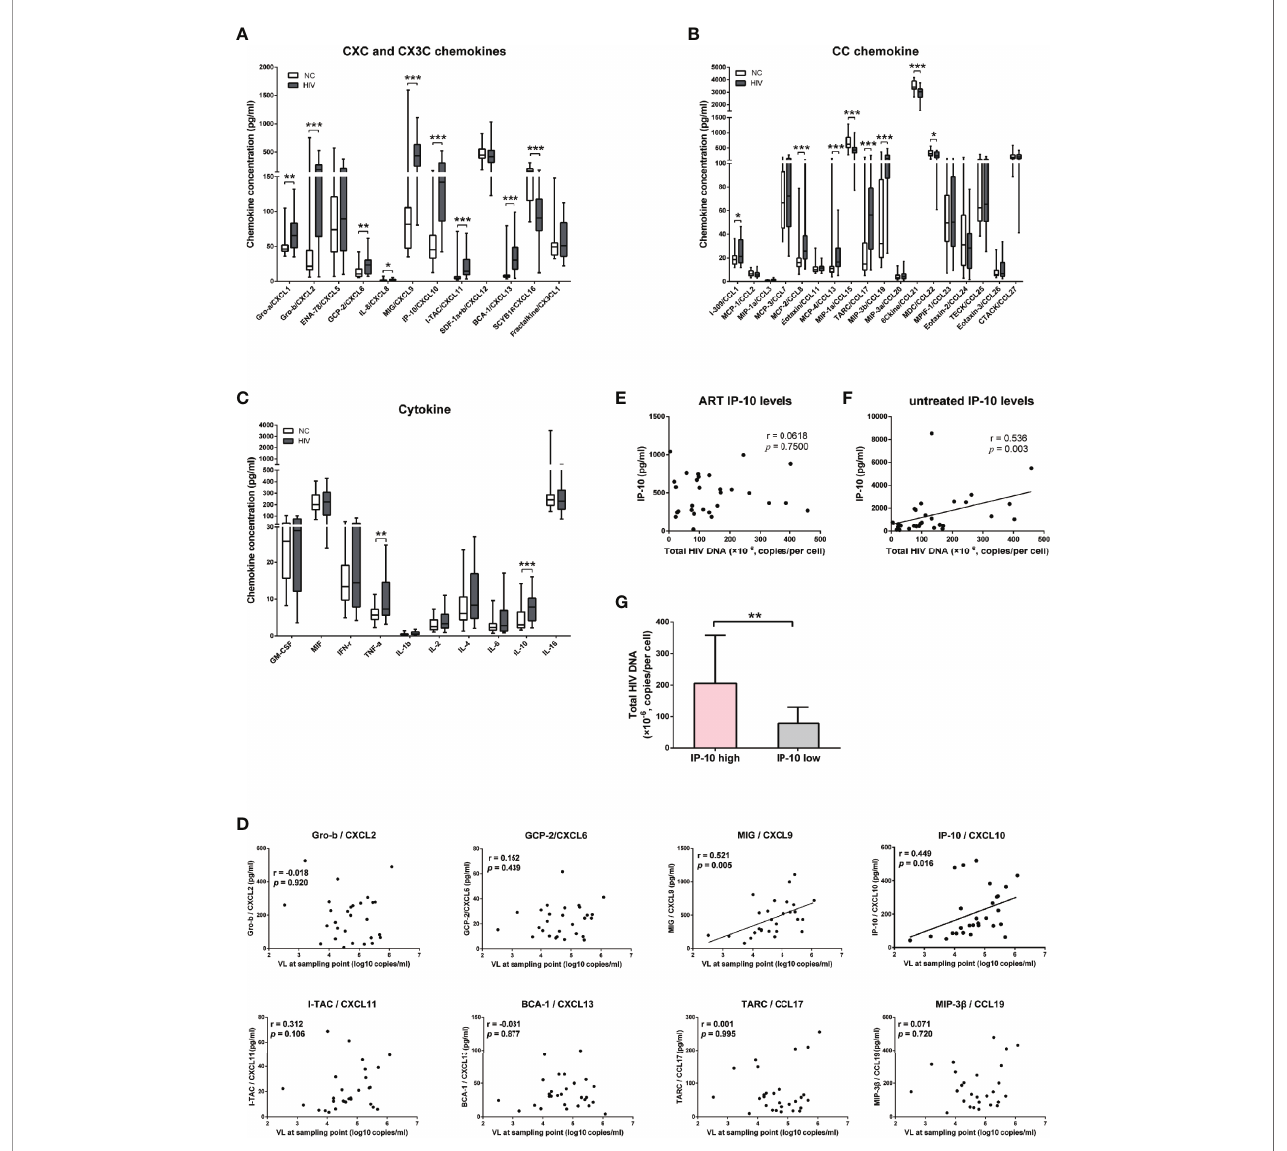
FIGURE 1 | IP-10/CXCL10 level is elevated in the chemokine pro fi le of HIV + participants, and positively correlated with viral load and HIV reservoir size. (A – C) Comparison of 11 CXC chemokines and 1 CX3C chemokine (A) ; 8 CC chemokines (B) ; and 10 cytokines (C) between HIV+ participants (gray bars, n=28) and NCs (white bars, n=24). Graphs show data as median ± interquartile range. The nonparametric Wilcoxon matched-pairs test was used for intergroup comparisons. (D – F) Spearman correlation analyses of chemokine (Gro-b/CXCL2, GCP-2/CXCL6, MIG/CXCL9, IP-10/CXCL10, I-TAC/CXCL11, BCA-1/CXCL13, TARC/CCL17, and MIP-3 b /CCL19) levels and viral load at indicated time points (D) ; and between total HIV DNA of PBMCs and IP-10 level after ART (E) or without treatment (F) . (G) Comparison the total HIV DNA of PBMCs in IP-10 high vs IP-10 low groups (separated according to median IP-10 level in 29 ART-treated HIV + participants). The nonparametric Mann – Whitney U test was used for intergroup comparisons (IP-10 high: N=13; IP-10 low: N=16, P =0.001). * P < 0.05, ** P < 0.01, *** P <